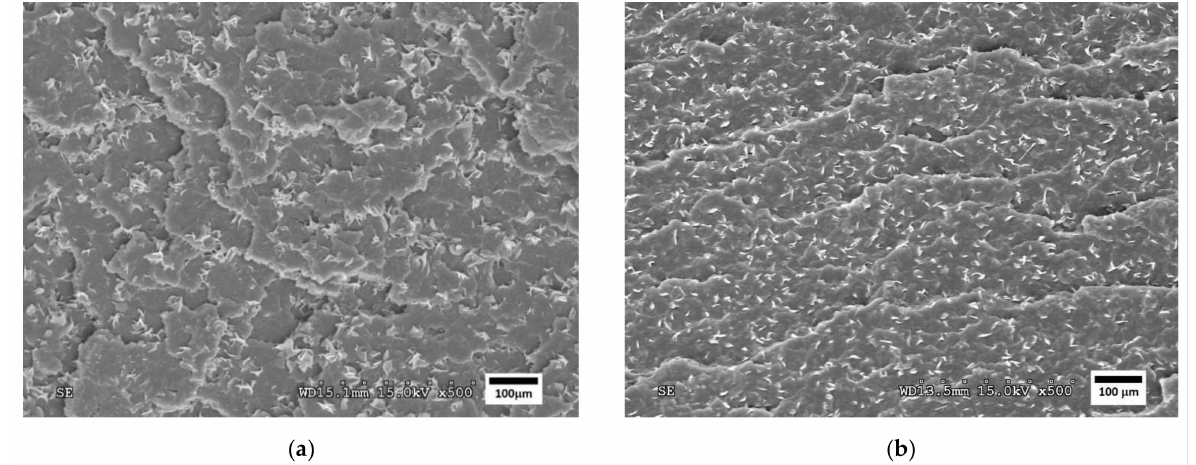
Figure 5. SEM micrographs of fractured surfaces at 500 × of ( a ) PHA80PBS20 and ( b ) PHA60PBS40